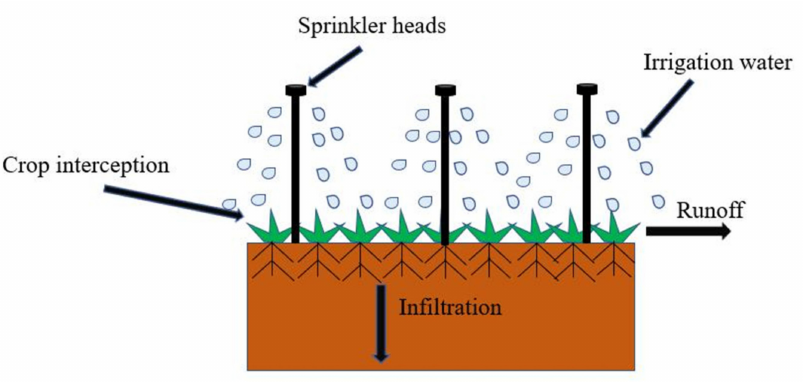
Figure 2. Spray irrigation soil hydrology